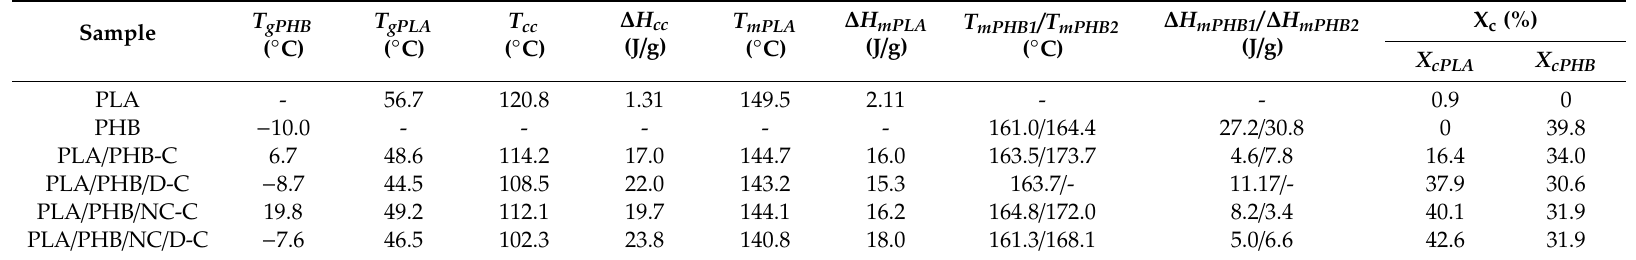
Table 2. DSC data corresponding to the first heating scan for PLA / PHB blends and